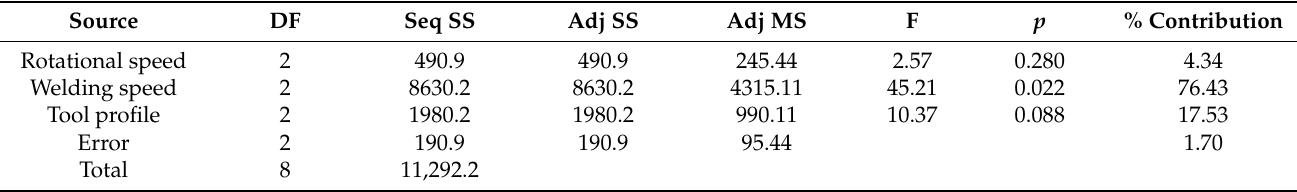
Table 8. Analysis of variance for the means of tensile strength.